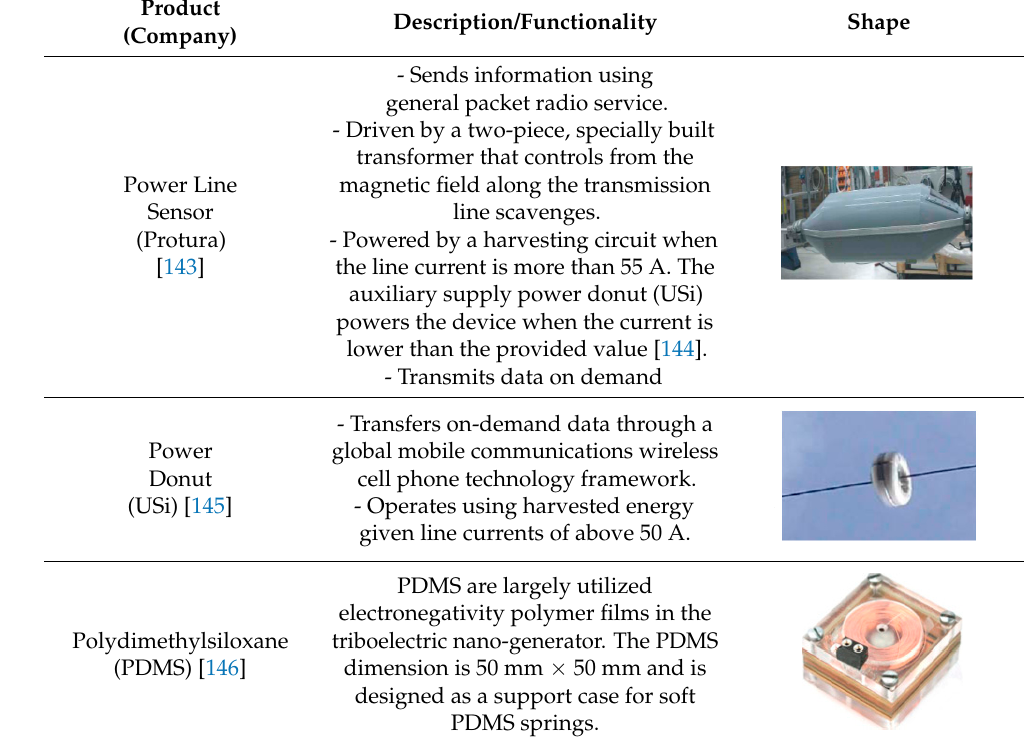
Table 4. Market survey of magnetic field-based items for energy harvesting.